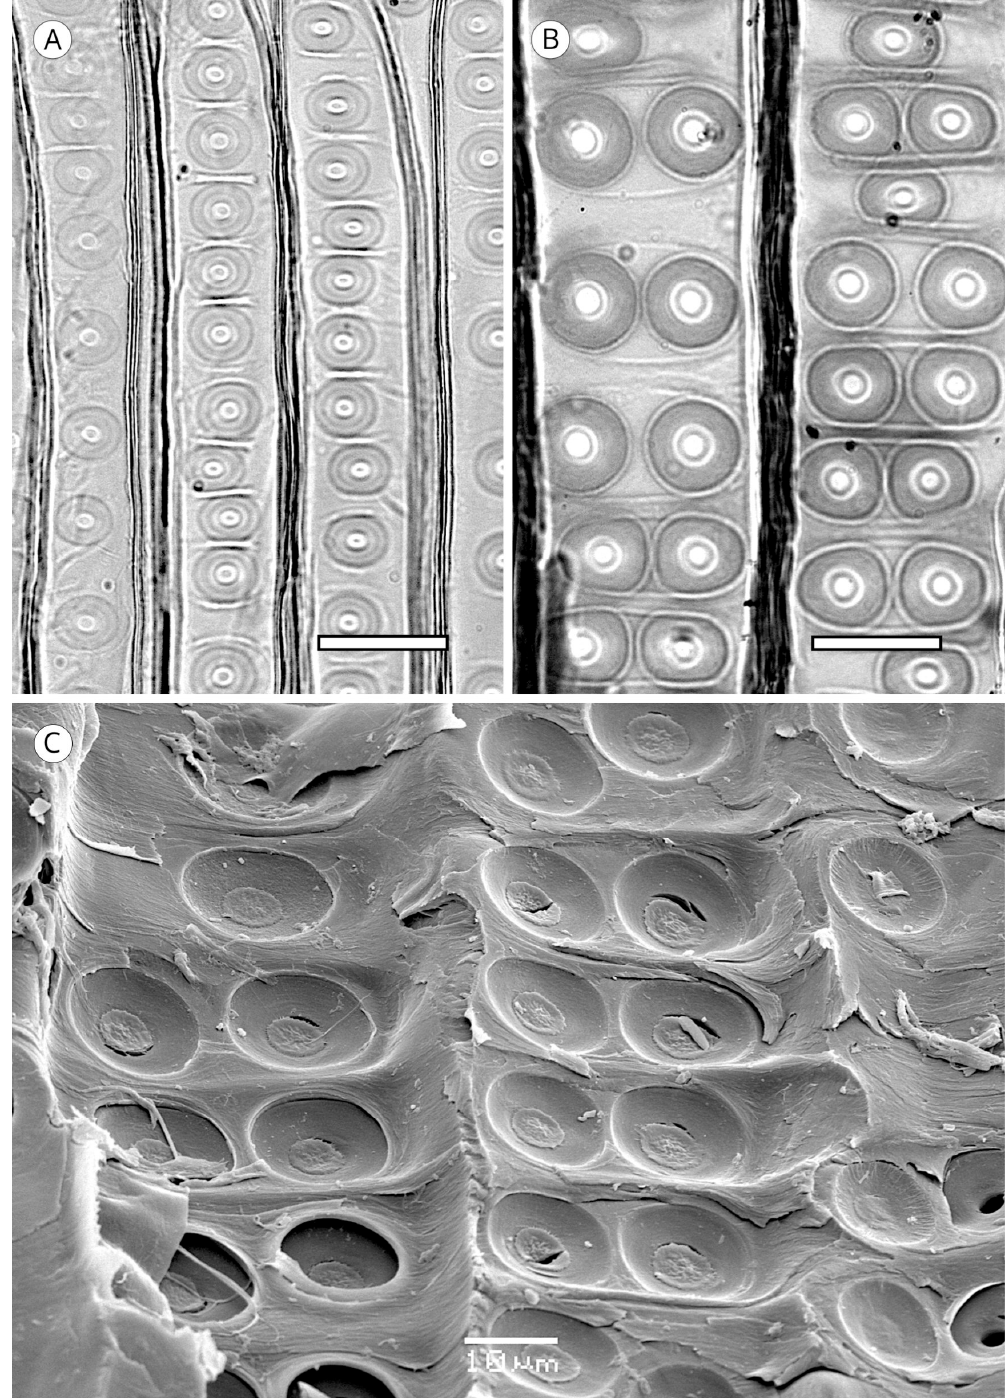
Figure 24. Bars of Sanio. ( A ) In uniseriate pits of Pinus elliottii Engelm.; ( B ) In biseriate pits in opposite arrangement in Pinus montezumae Lamb.; ( C ) In biseriate pits in opposite arrangement in Neocallitropsis pancheri (Carrière) de Laub. (SEM). Scale bars. ( A , C ) = 25 μ m; ( B ) = 10 μ m.